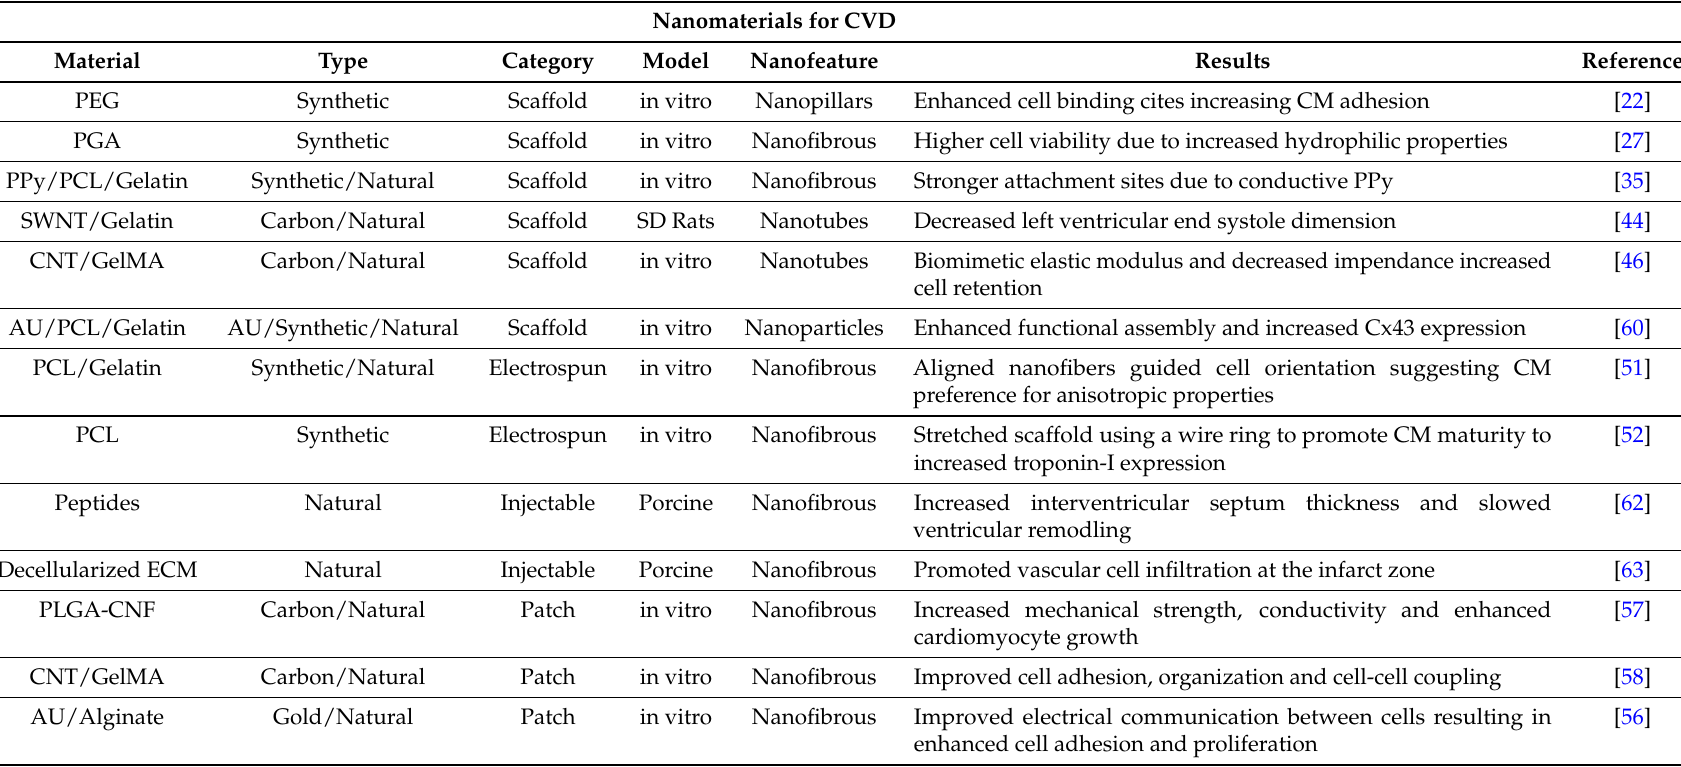
Table 1. To address the problem of post heart attack left ventricular dysfunction, scaffolds, patches, and injectables exploiting the superior characteristics of nanomaterials are a potential therapy for tissue myocyte